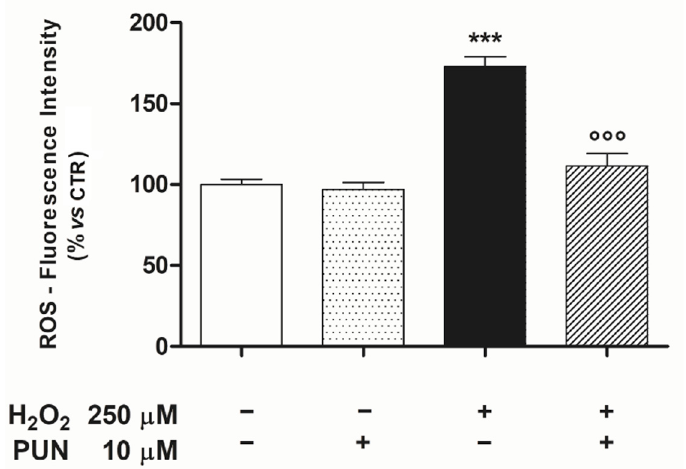
Figure 2. It was possible to reduce the H 2 O 2 –induced increase of mitochondrial ROS levels by pre–treating the ARPE–19 cells with PUN for 24 h. Values are expressed as percentages relative to the untreated control (100%) and are presented as means ± SEM of data from two distinct experiments, each in quadruplicate. One–way ANOVA analysis was carried out followed by post hoc Newman–Keuls test. Note: *** = p < 0.001 vs. control; °°° = p < 0.001 vs. 250 µM H 2 O 2 alone.